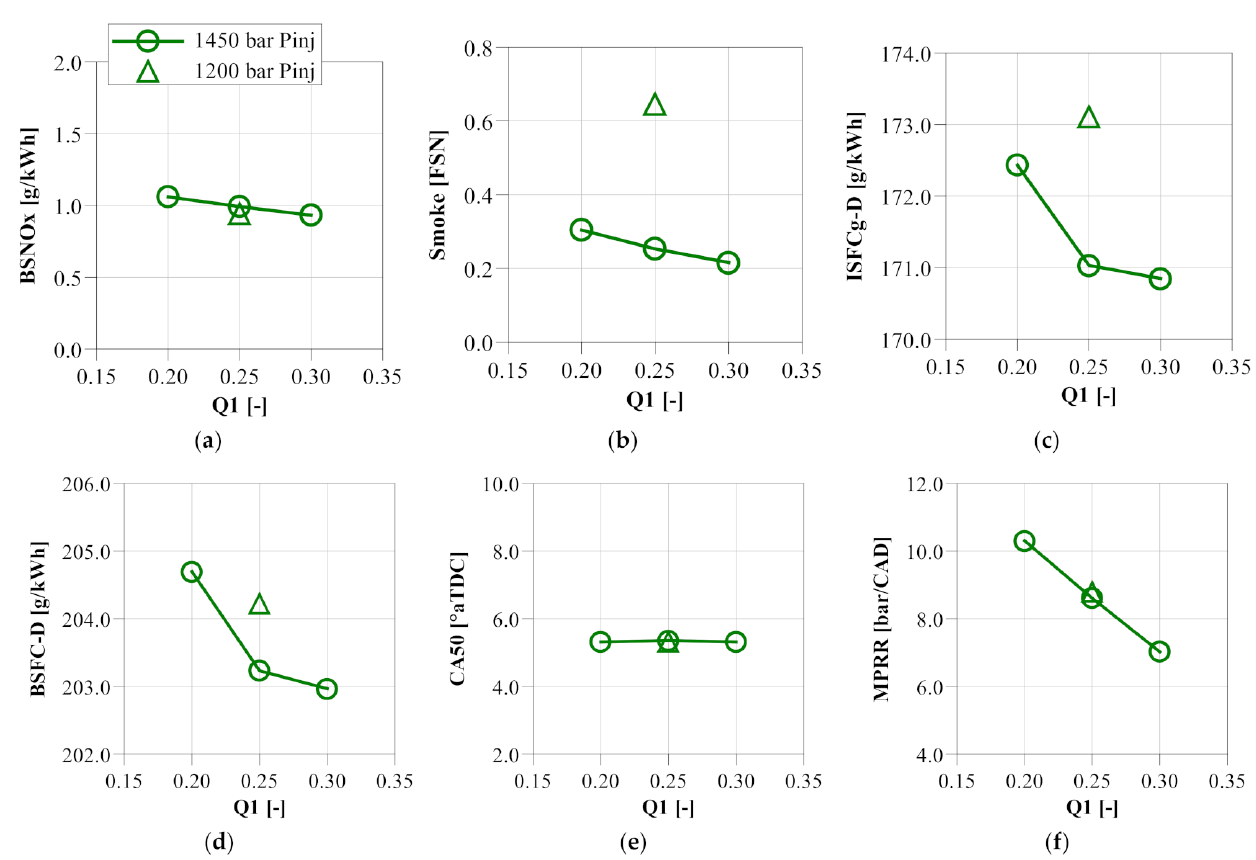
Figure 15. Overview of the performance results from fuel injection strategy investigation at B50: ( a ) BSNOx; ( b ) smoke; ( c ) ISFCg-D; ( d ) BSFC-D; ( e ) CA50; ( f )